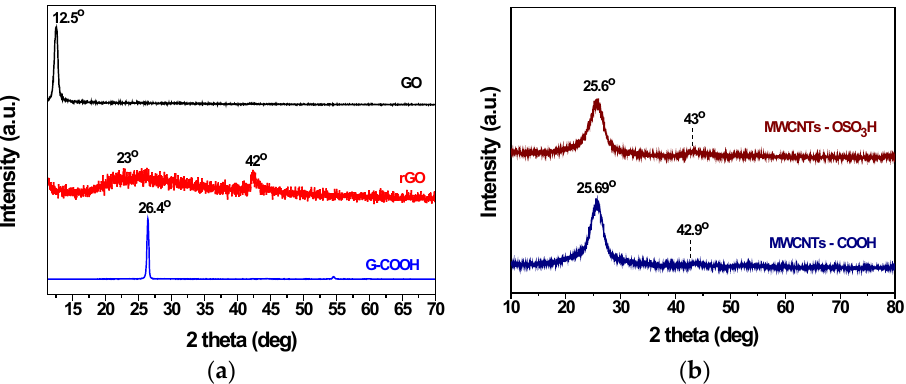
Figure 2. XRD patterns of ( a ) Graphene Oxide (GO), reduced Graphene Oxide (rGO) and Carboxylated Graphite (G-COOH) and of ( b ) MWCNTs carboxylated and sulfonated, respectively.